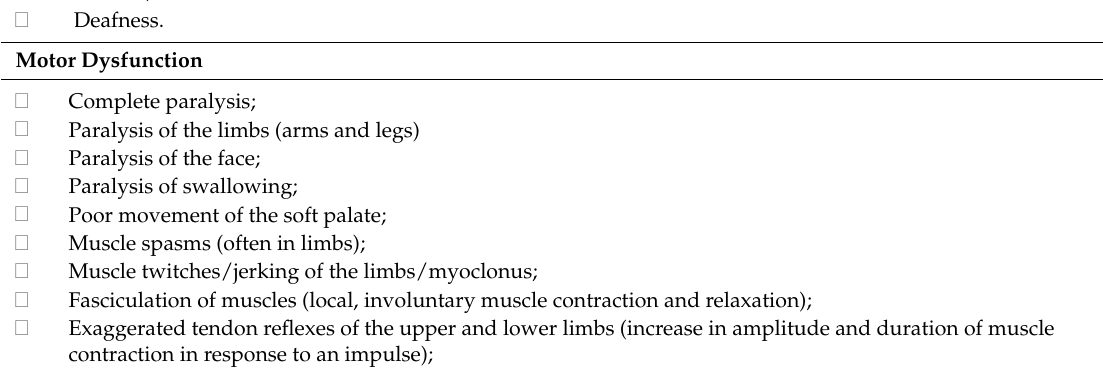
Table 3. Neurological symptoms of patients observed in endemic and epidemic cases [1,3]. Cognitive Dysfunction Autonomic Dysfunction